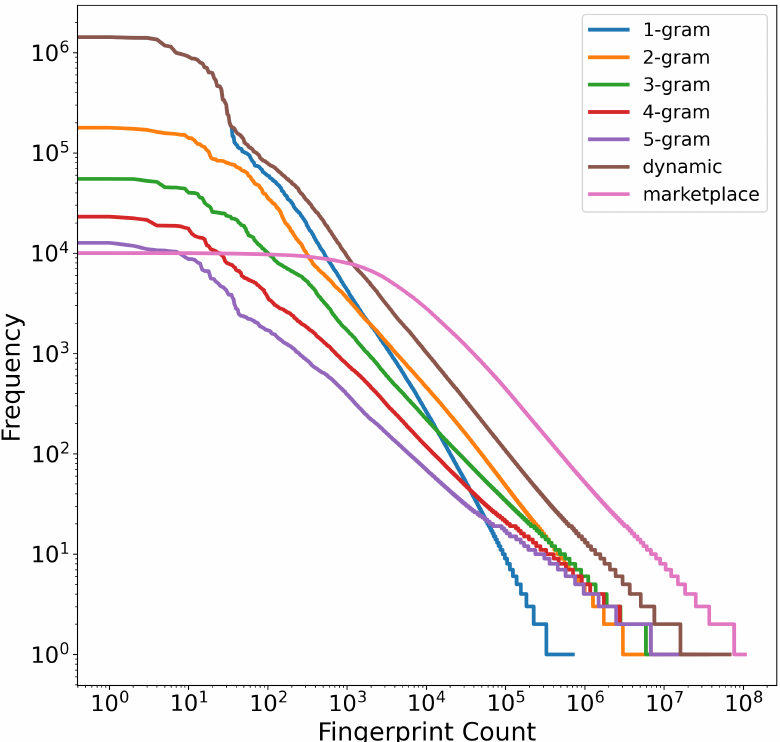
Figure 9. Distribution of fingerprint frequency. For each system, the set of unique fingerprints in the database is sorted by frequency of occurrence and shown from most frequent (left) to least frequent (right). The marketplace system avoids fingerprints that are either extremely common or extremely rare. Note that both axes are on a log